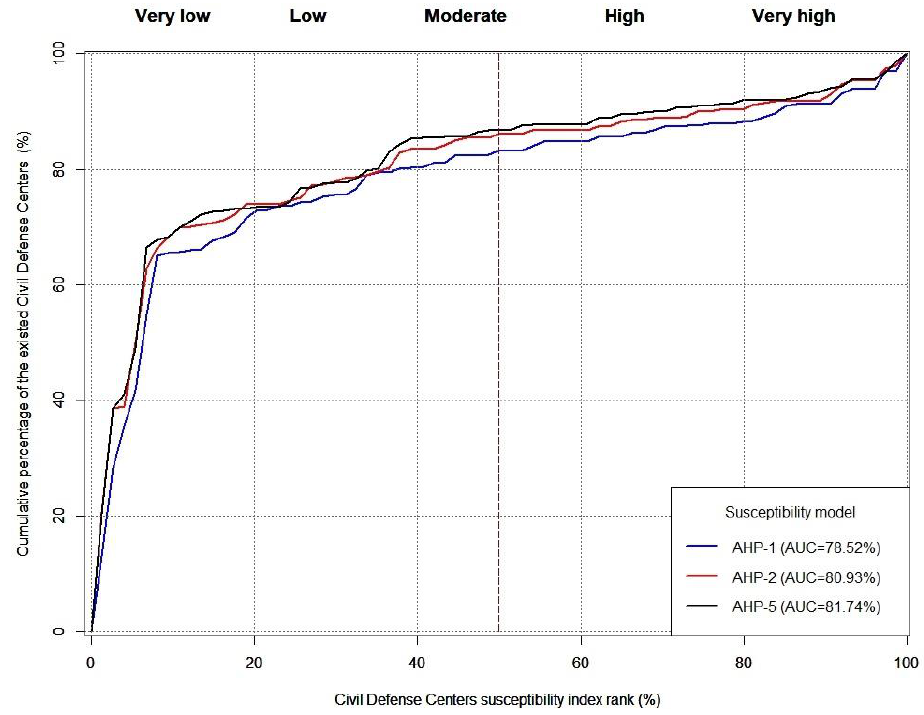
Figure 10. PRC plot evaluation of the three best CDC models after adding the existing and proposed CDCs.